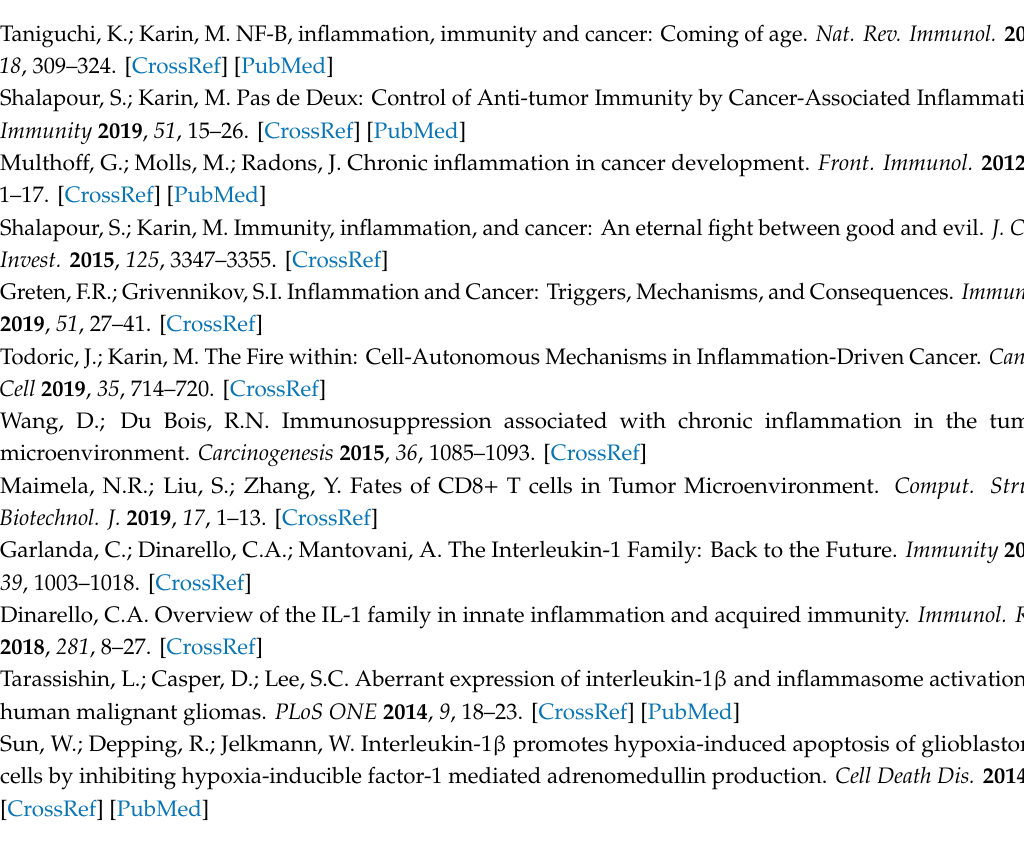
Figure S1: (A) Dose-finding analysis of IL-1 β . (B) Dose-finding analysis of anakinra. (C) mRNA expression of proinflammatory IL-1 β , COX2, IL-8 and IL-6 in U87 cells, Figure S2: Analysis of chemotaxis time-lapse microscopy by single-cell tracking of primary GBM cells, Figure S3: (A) mRNA expression of STAT3 in T98G cells after stimulation with IL-1 β in the present or absence of anakinra, as analyzed by qRT-PCR. (B) Percentage of apoptotic T98G cells after stimulation with IL-1 β , in the present or absence of anakinra, as measured by flow cytometry, Table S1: Primer sequences for qRT-PCR, Table S2: Patient